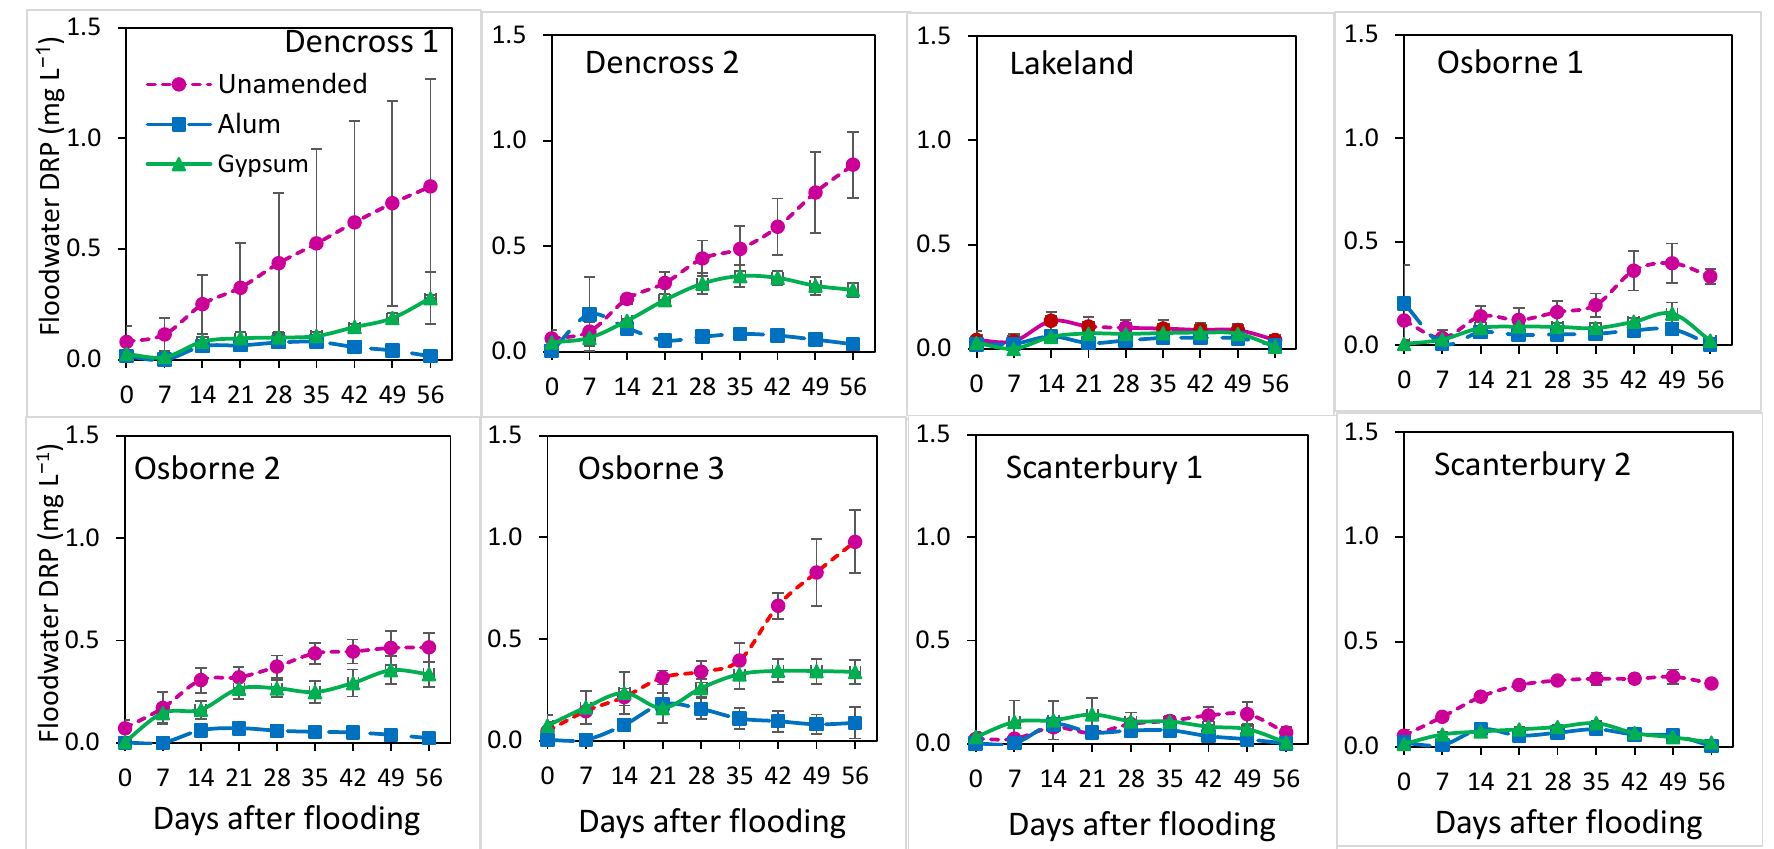
Figure 2. Mean floodwater dissolved reactive P concentrations in unamended, alum-amended and gypsum-amended soil monoliths with time of flooding. The vertical bars indicate the standard deviation of the means (n = 3).